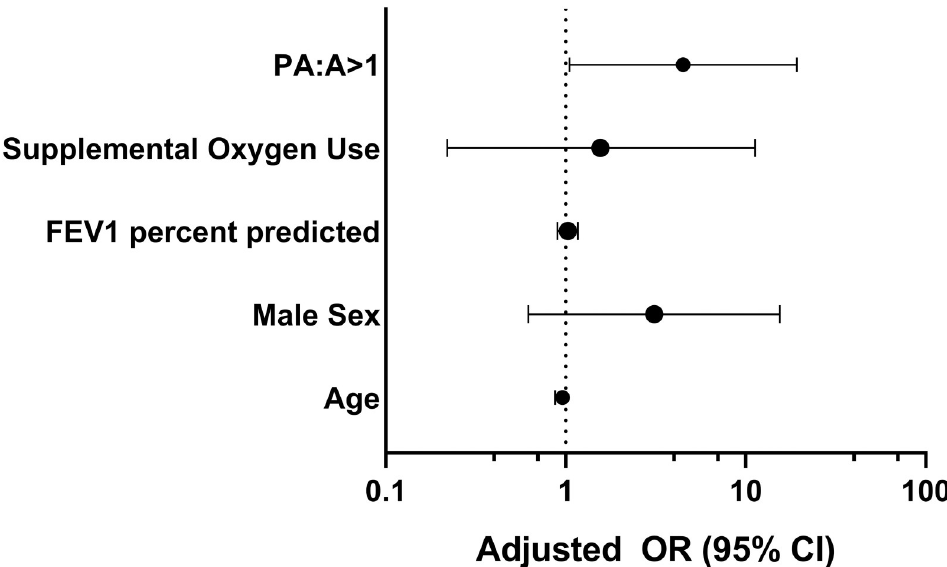
Fig 3. Associations between PA enlargement and pulmonary hypertension measured at right-heart catheterization in cystic fibrosis. PA enlargement was associated with PH defined by mPAP � 25 mmHg ( � P < 0.05) in logistic regression models adjusted for age, sex, FEV1 percent predicted, and supplemental oxygen use. Abbreviations: CI = confidence interval; FEV1 = forced expiratory volume in 1-second; PA:A = pulmonary artery diameter to aorta diameter